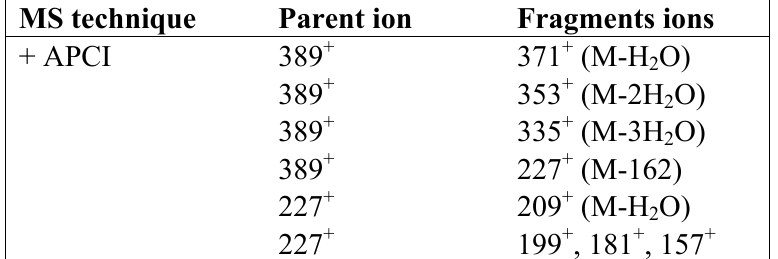
Table 1. MS/MS measurements of 2,4,6-trihydroxyphenanthrene-2- O